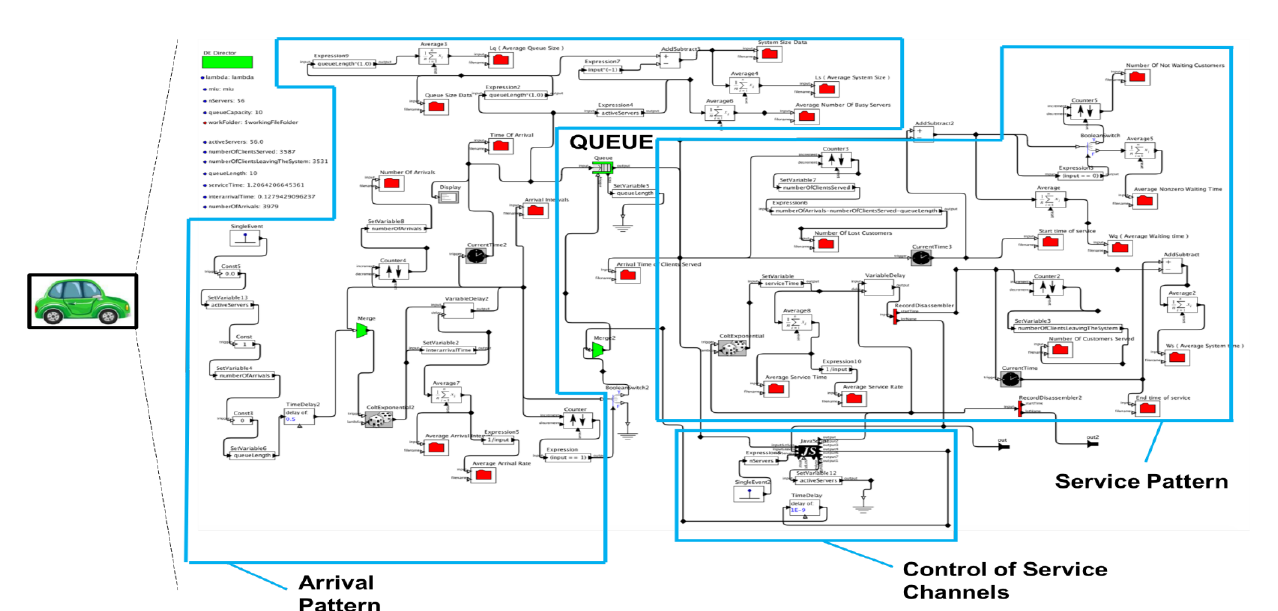
Figure 7. Vehicle arrival/departure model based on an M/M/c/N queuing system.